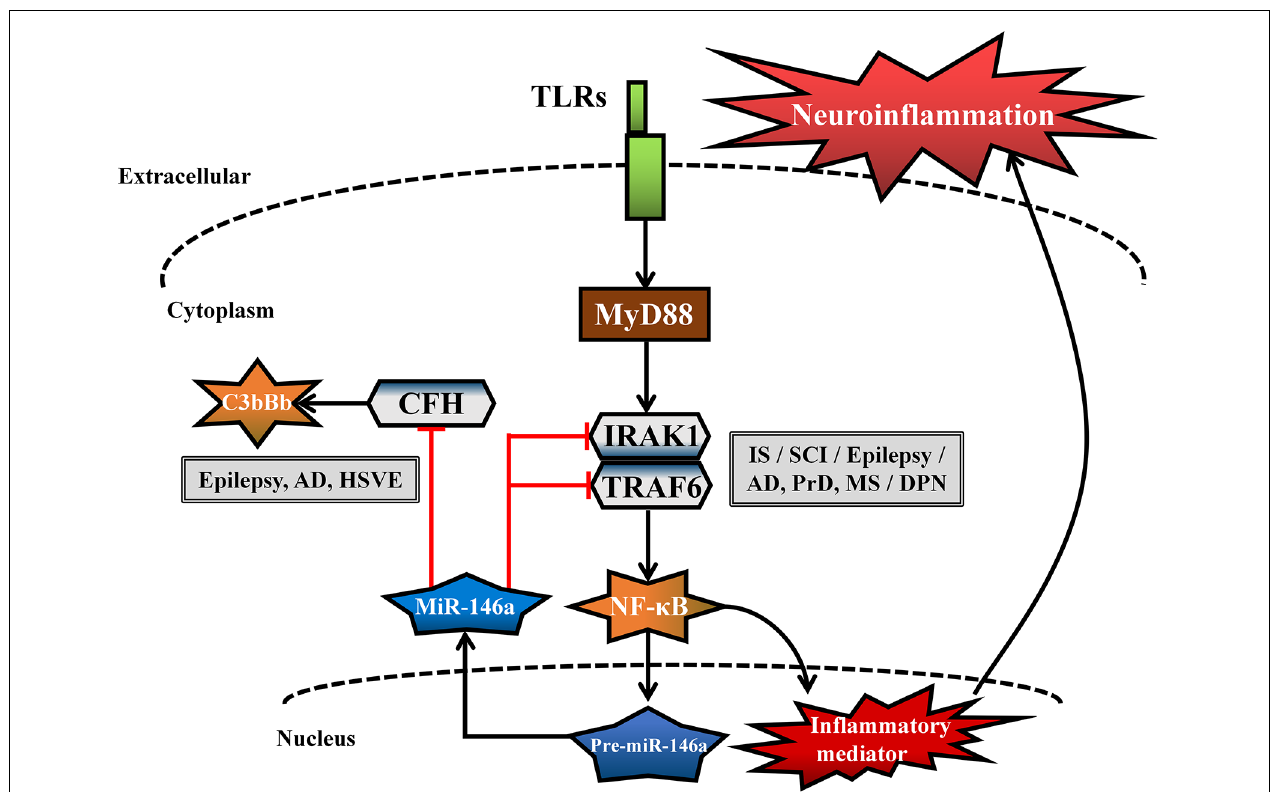
FIGURE 4 | Common neuroinflammatory pathways in different neurological diseases regulated by miR-146a. The common genes [interleukin-1 receptor-associated kinase-1 (IRAK1), tumor necrosis factor receptor-associated factor 6 (TRAF6), complement factor H (CFH)] and related pathways [Toll-like receptor (TLR) signaling pathway and complement activation pathway] regulated by miR-146a are involved in the neuroinflammatory response in different neurological